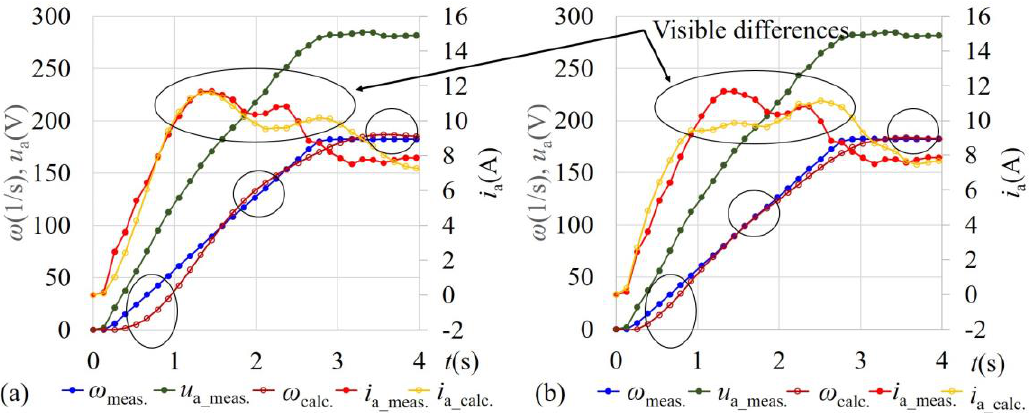
Figure 11. Measured and calculated responses in the case of MD4 using: ( a ) EM; ( b ) RK.